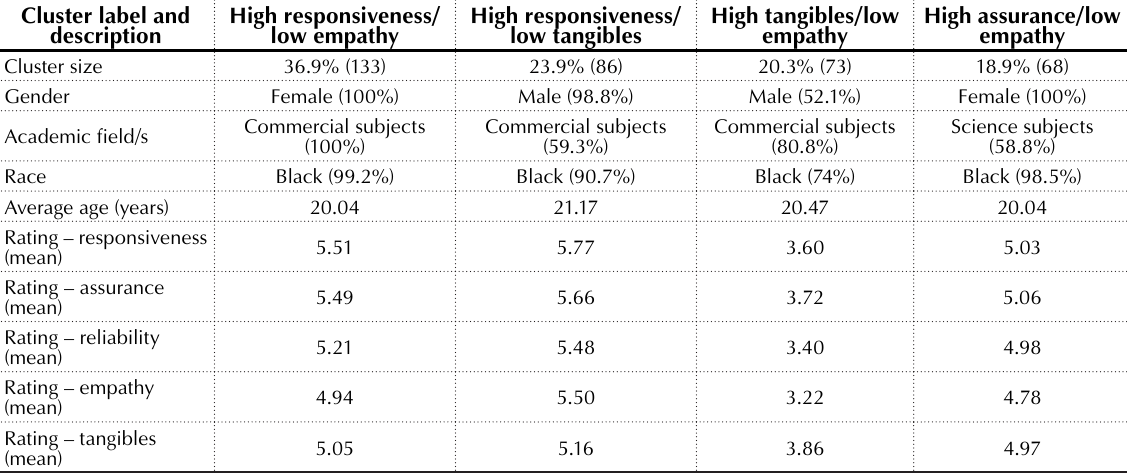
Table 7. Service quality dimensions and demographic factors Cluster label and